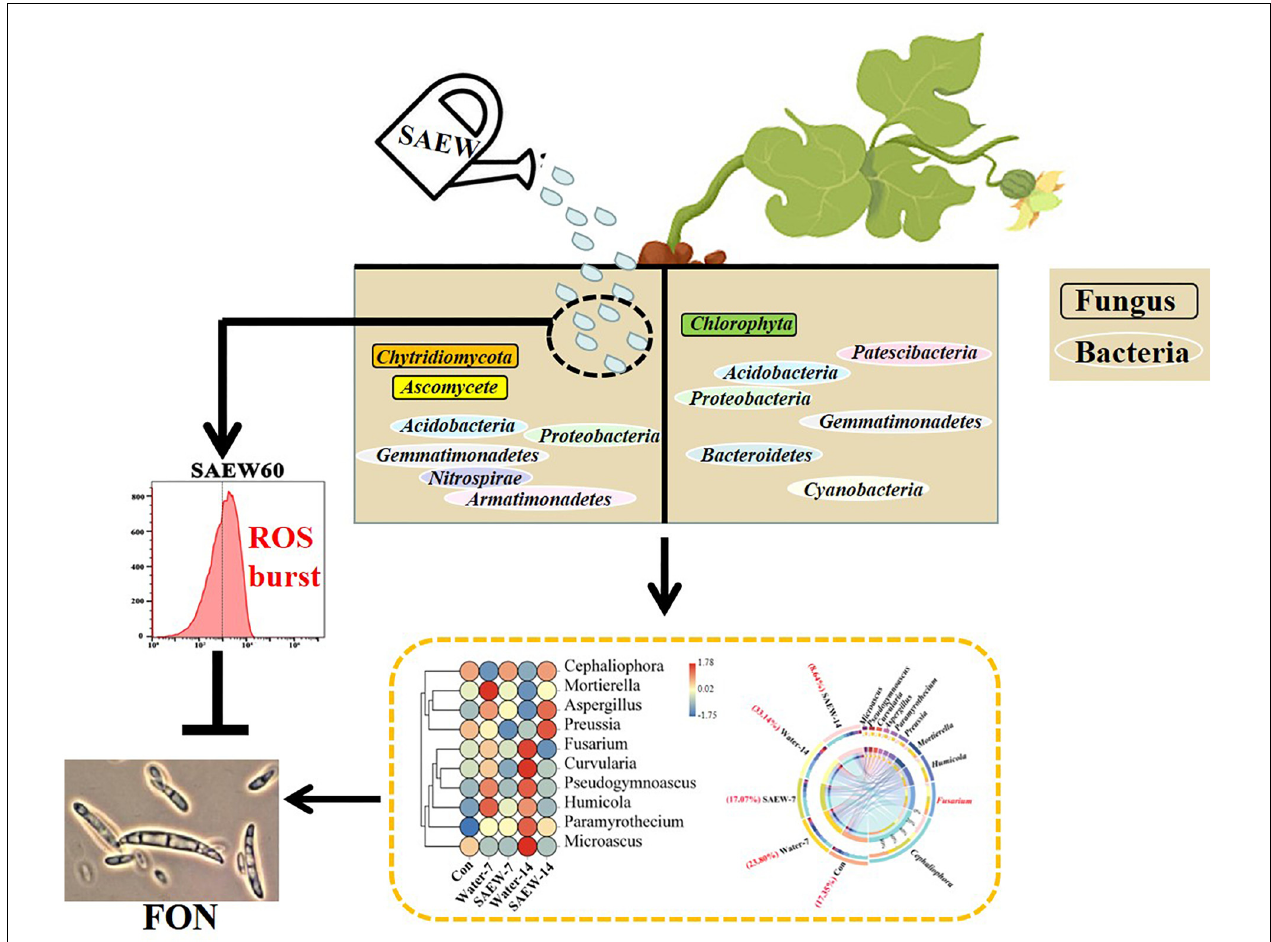
FIGURE 7 | The mechanism model of SAEW alleviated watermelon continuous cropping obstacle. The left and the right halves of soil in the graph show the soil with or without SAEW treatment, respectively. SAEW could significantly improve the growth of watermelon seedlings grown in continuous cropping soil. The bacterial diversity in soil was reduced but the fungal diversity was induced by SAEW. The corresponding indicator species are marked in the model. The white oval and black rectangle separately represent the bacterial and fungal indicator species of different treatments. Thereinto, the proportion of FON was remarkably decreased by SAEW. The sterilization effect of SAEW was further verified by the analyses of FON mycelial growth, which may arise from the intracellular ROS production was greatly induced by SAEW treatment. ROS: Reactive oxygen species; FON: Fusarium oxysporum f. sp. niveum